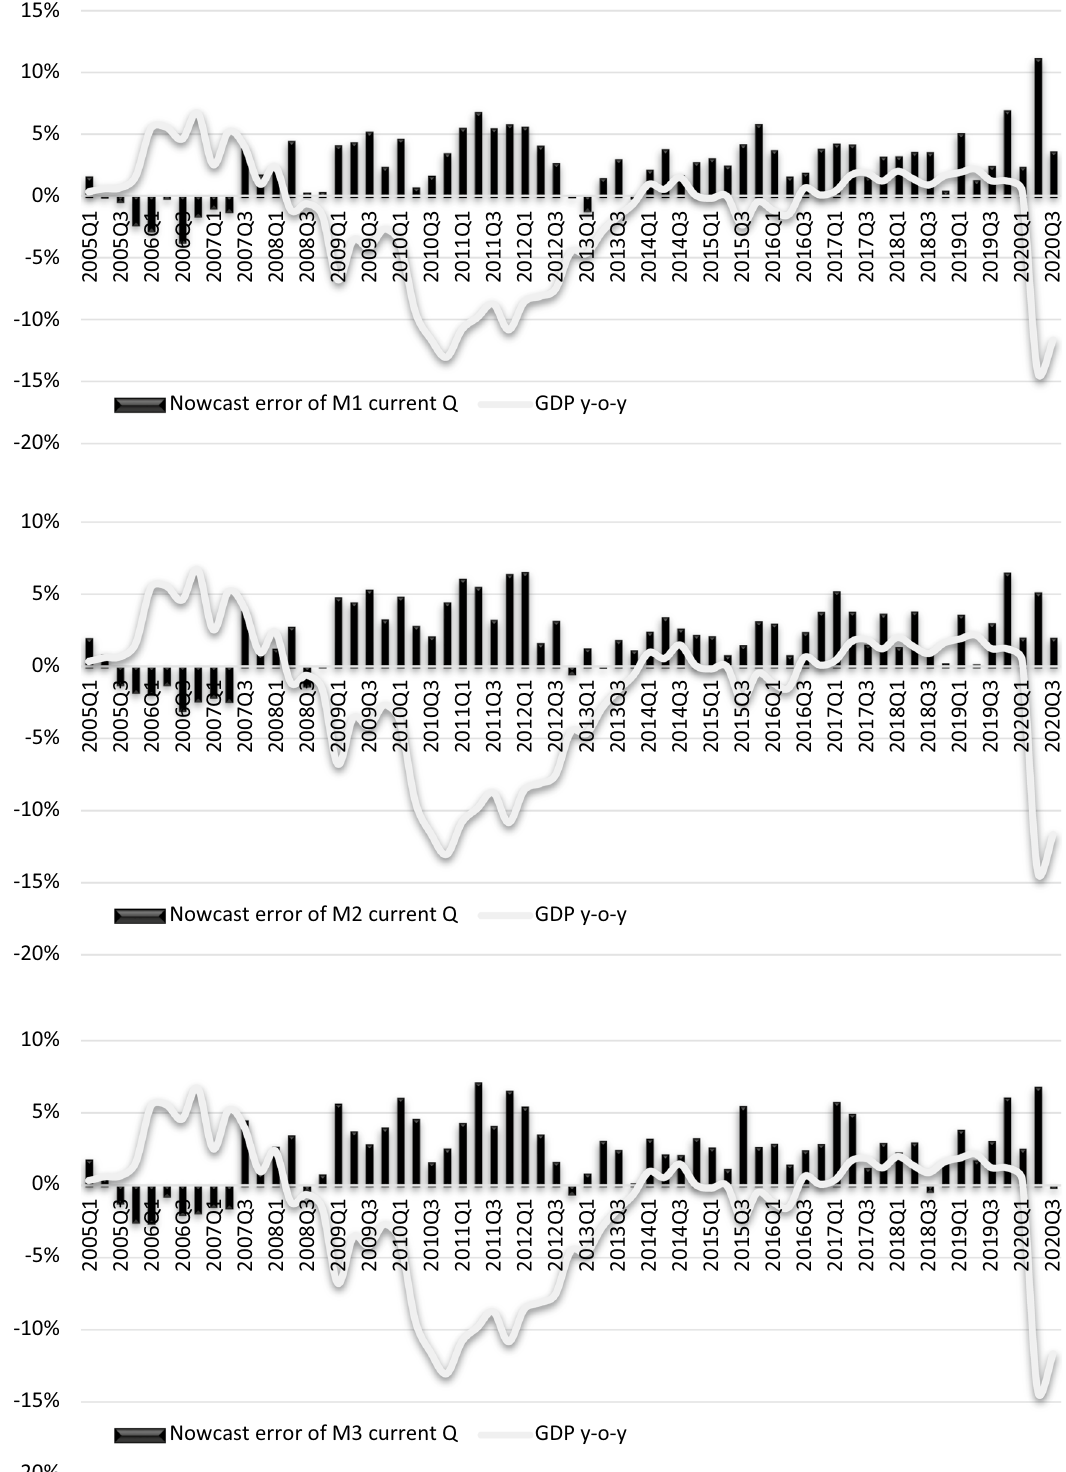
Y ( 0 ) q − Y ( 0 ) q / Y ( 0 ) q − 4 of the disaggregated Midas model. (i) The nowcasting error (cid:29) (cid:31) (cid:30)